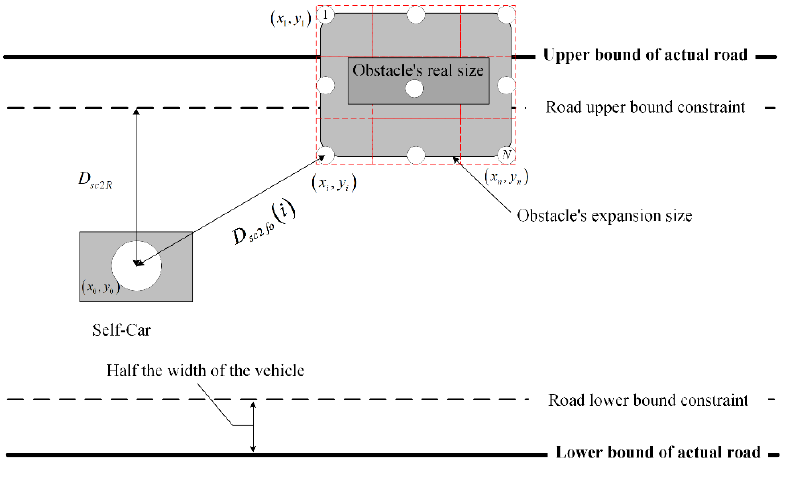
Figure 8. Obstacle expansion and the cost caused by parked